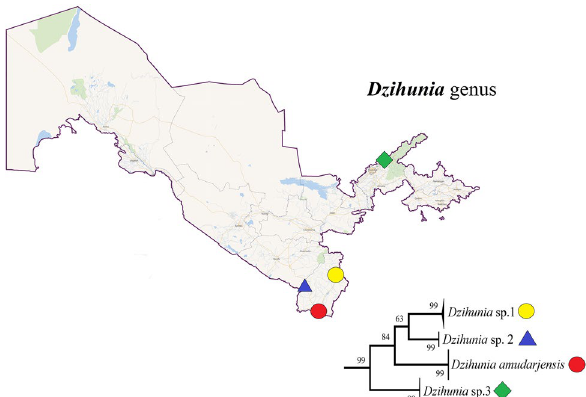
Figure 4. Neighbour-joining tree of Dzihunia spp. from DNA barcode sequences with 100,000 bootstrapping replicates. Sampling localities: lower Surkhan Darya (red circle) upper Surkhan Darya (yellow circle), Sherabad River (blue triangle) and Chirchik River (green